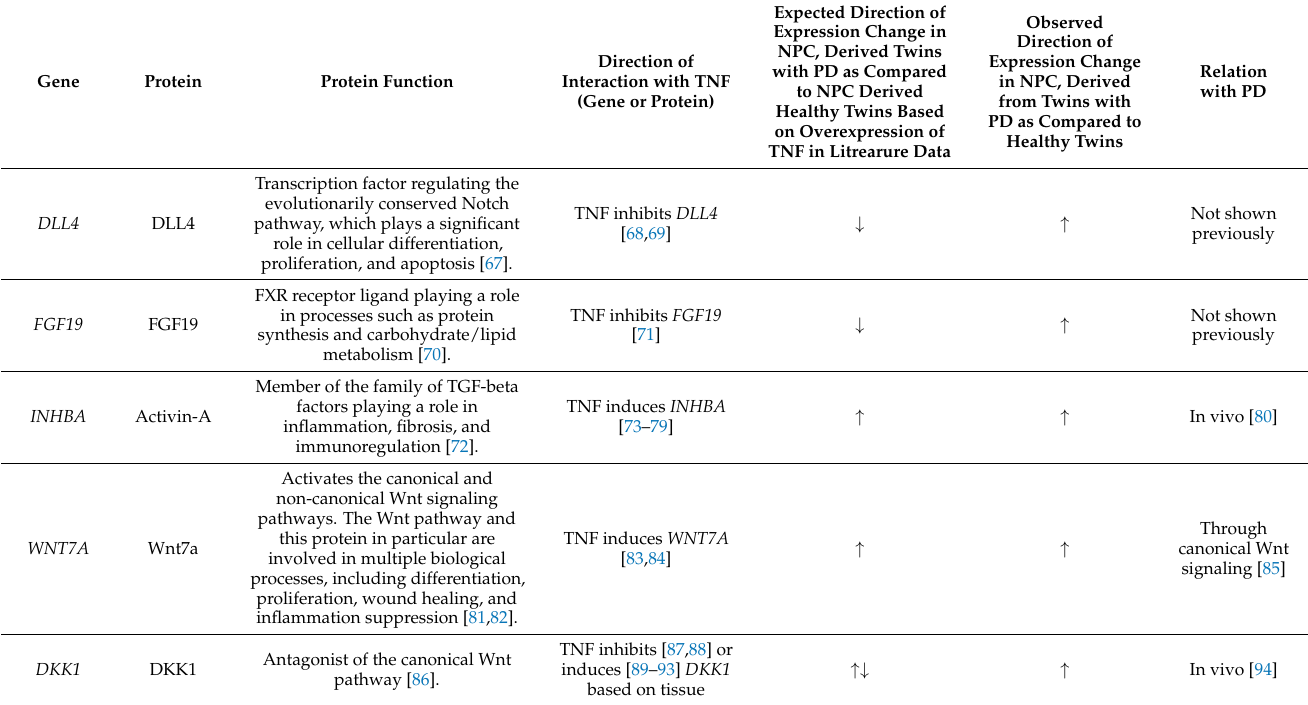
Table 4. Relation between DEG NPC, involved in groups I and II of GO BP with TNF based on data, found in literature. Gene Protein Protein Function